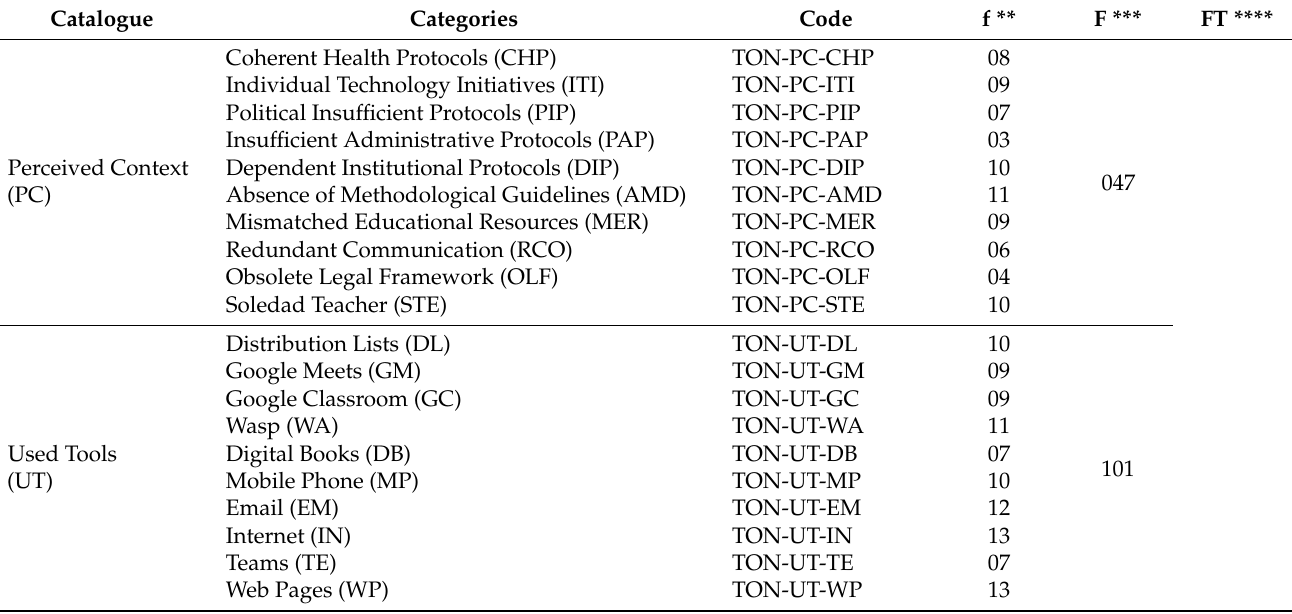
Table 8. Results that emerged in the segments of meaning obtained in the interviews and discussion groups for the qualitative analysis (carried out with Aquad